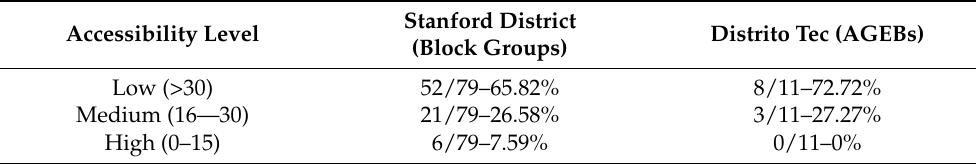
Figure 20. Stanford District average travel time to the closest public general acute care hospital or public primary care clinic by foot. Table 13. Accessibility level hospitals traveling by foot per aggregation area.